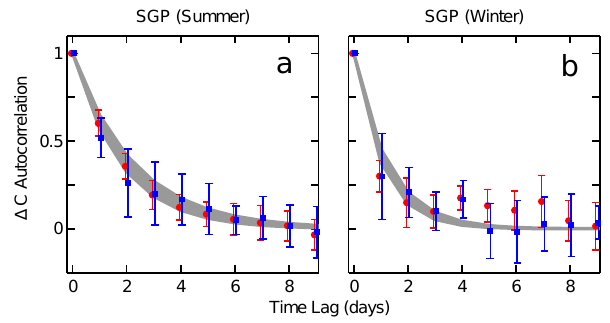
Fig. 8. Autocorrelation coefficient for perturbations in daily vertical mixing ratio gradients from aircraft and 60-m tower observations (blue square markers), and from CT/TM5 (red circle markers). Er- ror bars indicate the standard deviation of the mean over all years (2003–2005 for observations, 2001–2007 for CT/TM5). Panels (a) and (b) correspond to summer and winter, respectively. The gray line indicates exponential decay toward the 90-day average value, according to Eq. (7) (width of the line indicates the standard devia-